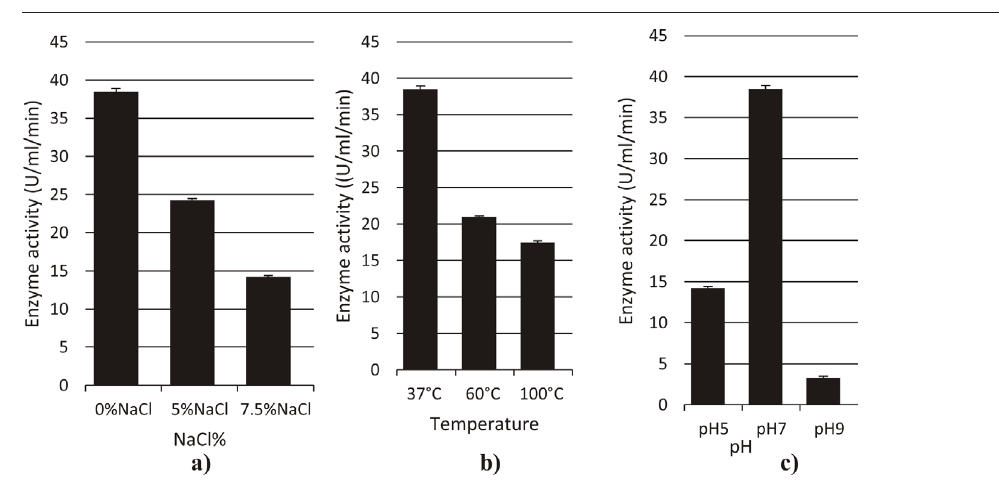
Fig. 8. Effect of different factors ( a : NaCl%, b : Temperature, c : pH) on activity of esterase enzyme from Streptomyces ghanaensis